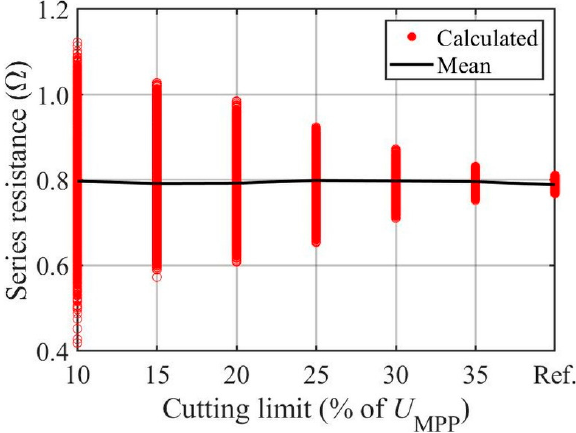
Figure 13. Fitted series resistance values during the 40 min measurement period as a function of the cutting limit based on MPP voltage.